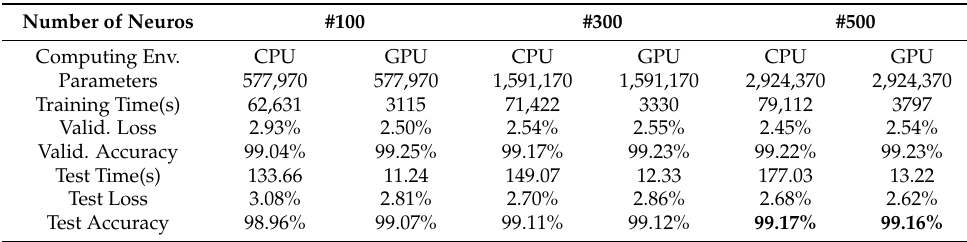
Table 5. Network performance of the two-channel CNN concatenated with a single-layer LSTM ar- chitecture. Number of Neuros #100 #300 Computing Env.